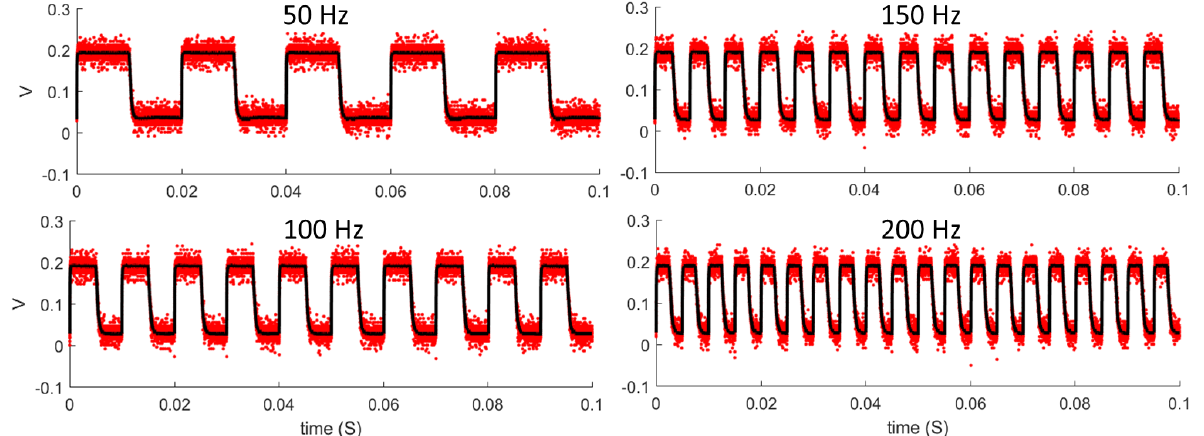
Figure 2. Luminous output measurements at four different frequencies. The red dots represent the raw individual measurements, while the black markers represent the average of these measurements at each time point.